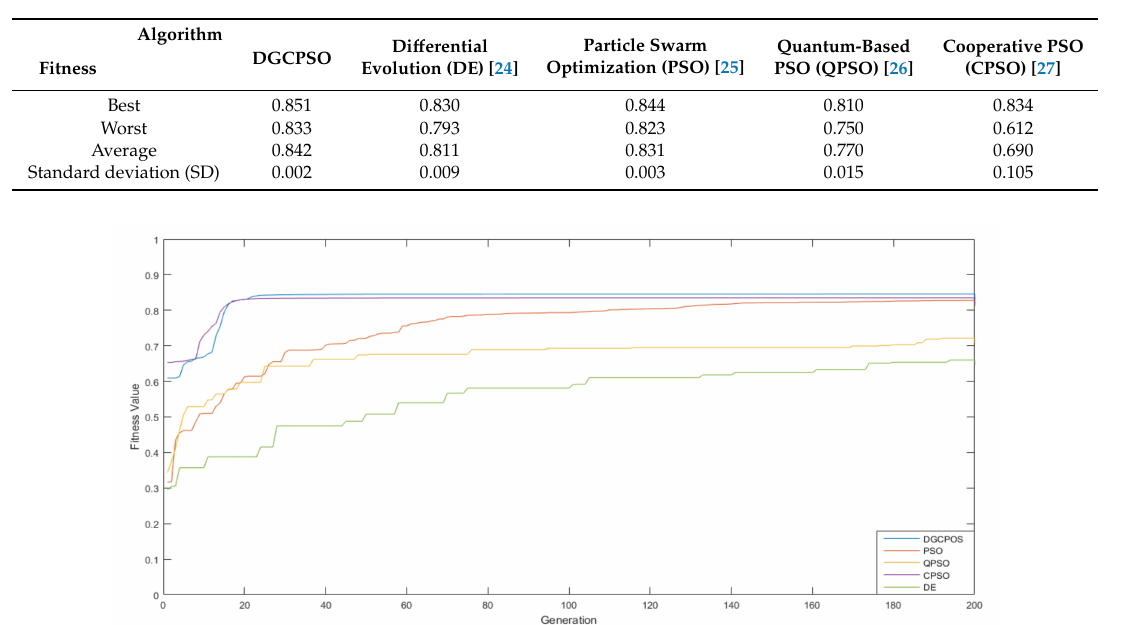
Table 2. Dynamic system identification.